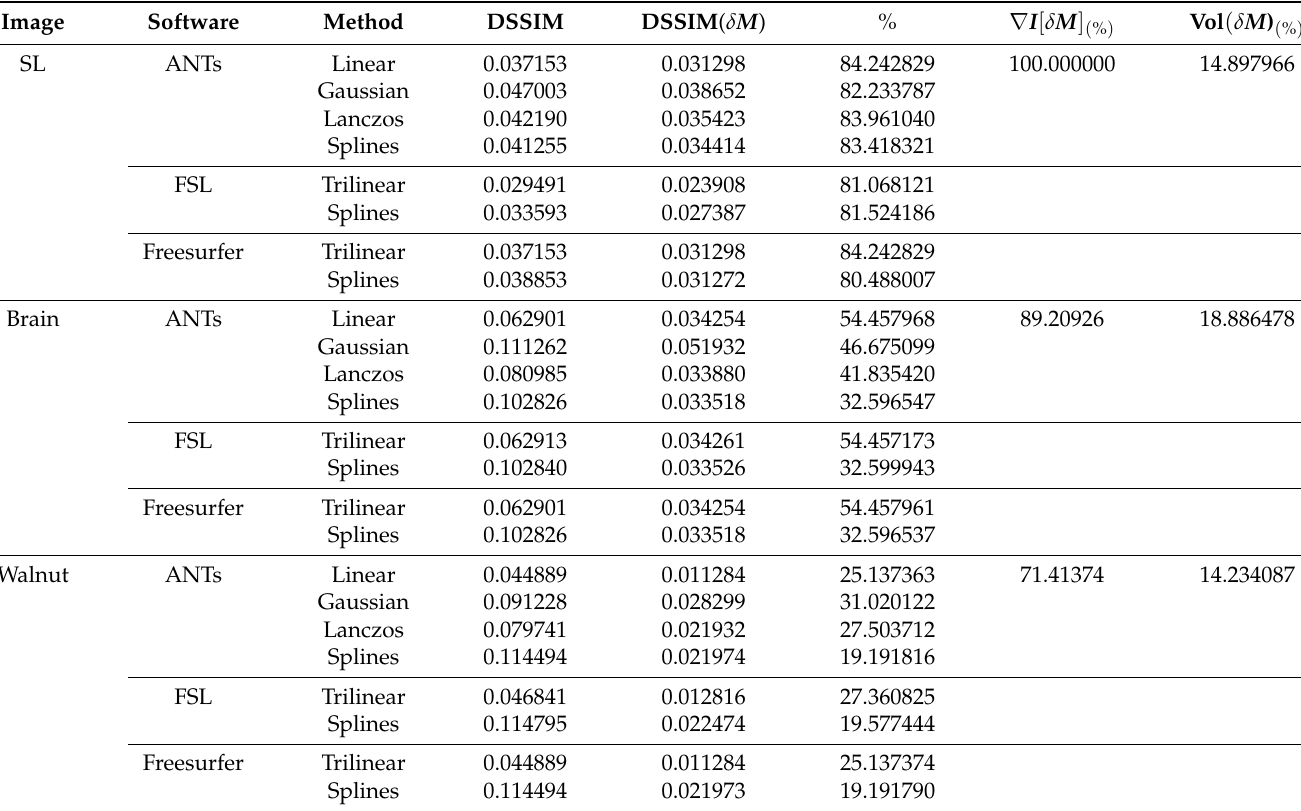
Figure 6. A slice of the Shepp–Logan phantom in High Resolution ( center ), and oversampled in FLS ( left ) and Freesurfer ( right ) using the Trilinear ( top ) and Splines ( bottom ) basis function, respectively. Table 4. Interpolation oversampling errors in terms of DSSIM ( I , F + ) (the smaller the better), DSSIM at the segmentation gradient at the borders δ M and percentage volume of δ M over the whole FOV. Empty cells indicate the same as